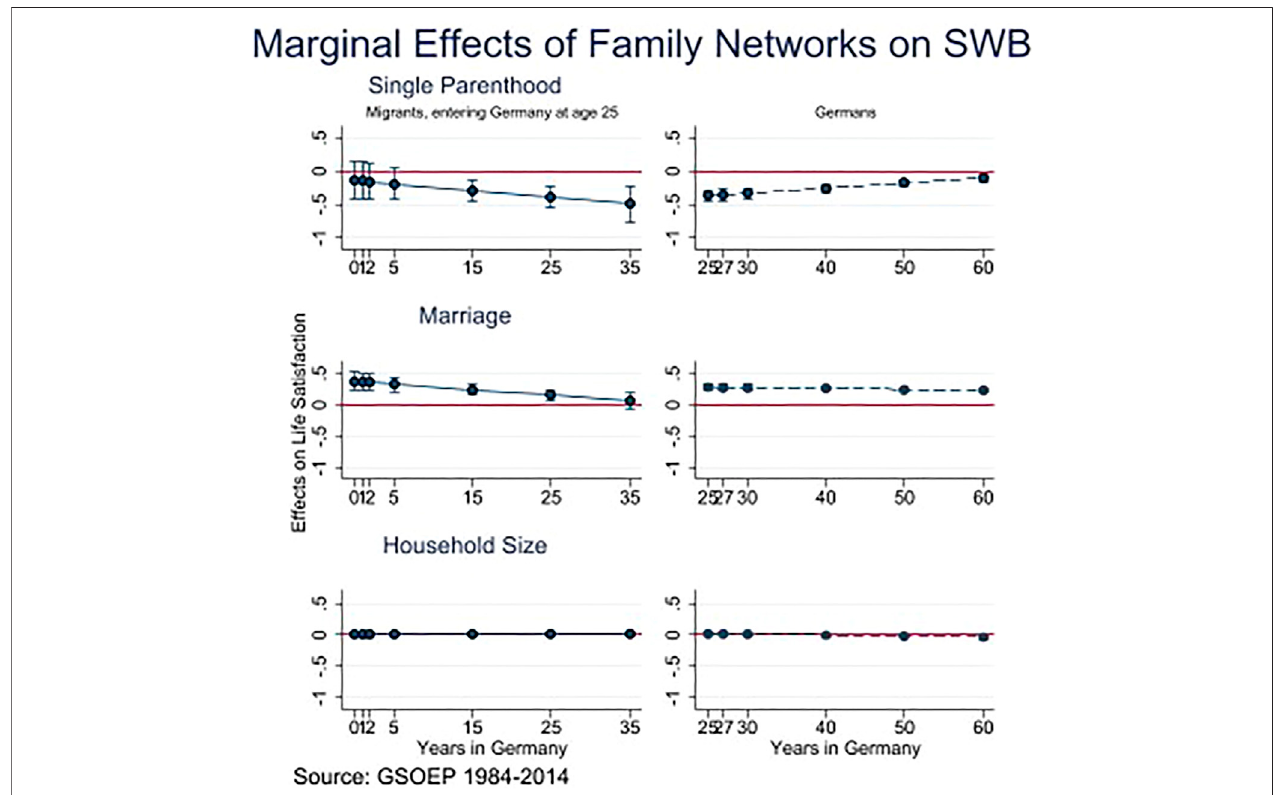
FIGURE 4 | Marginal effects of family networks on